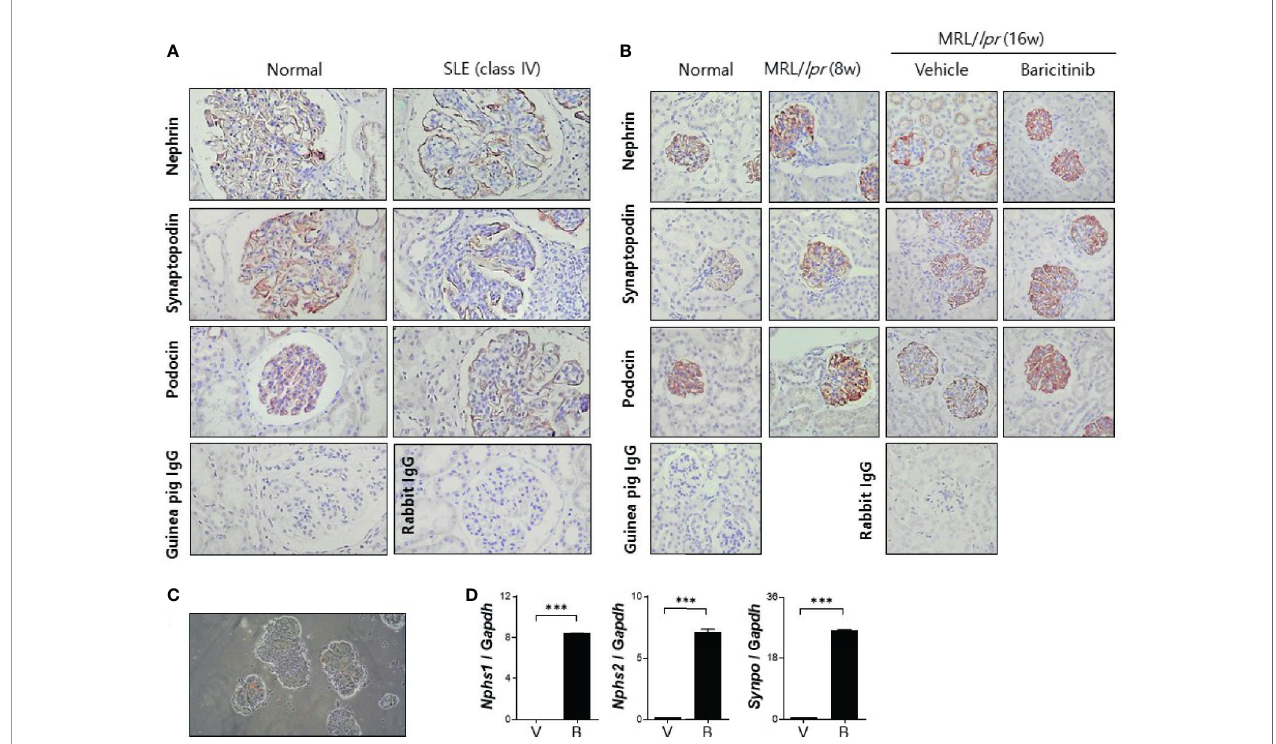
FIGURE 4 | Baricitinib increases expression levels of functional membranous molecules of podocytes including nephrin, synaptopodin, and podocin in MRL/ lpr mice. (A) Representative pictures of immunohistochemical staining of nephrin, synaptopodin, and podocin in human kidneys (original magni fi cation ×100) (normal control: left panel; a female patient with lupus nephritis ISN/RPS class IV: right panel). Expression levels of membranous molecules of podocytes were decreased in the glomeruli of patients with lupus nephritis. (B) In vivo treatment with baricitinib increases the expression of nephrin, synaptopodin and podocin in kidneys of 16-week- old MRL/ lpr mice. Representative images of immunohistochemical staining of nephrin, synaptopodin, and podocin in kidneys of 16-week-old MRL/MpJ mice (normal controls), 8-week-old MRL/ lpr mice, and 16-week-old MRL/ lpr mice treated with vehicle or baricitinib are shown (original magni fi cation ×400). (C) Representative images of glomeruli isolated from 16-week-old MRL/ lpr mice are shown (original magni fi cation ×400). (D) mRNA levels of Nphs1 (nephrin), Nphs2 (podocin), and Synpo (synaptopodin) from pooled glomeruli of eight mice of each group were determined by real-time PCR. Data are expressed as mean ± SD. *** p <